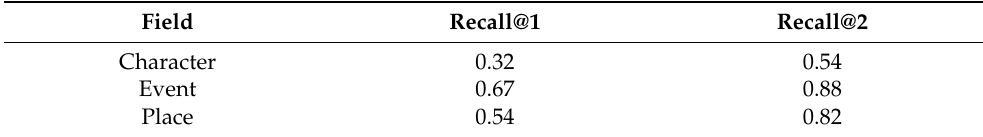
Table 1. Automatic evaluation results of storyline guidance model.